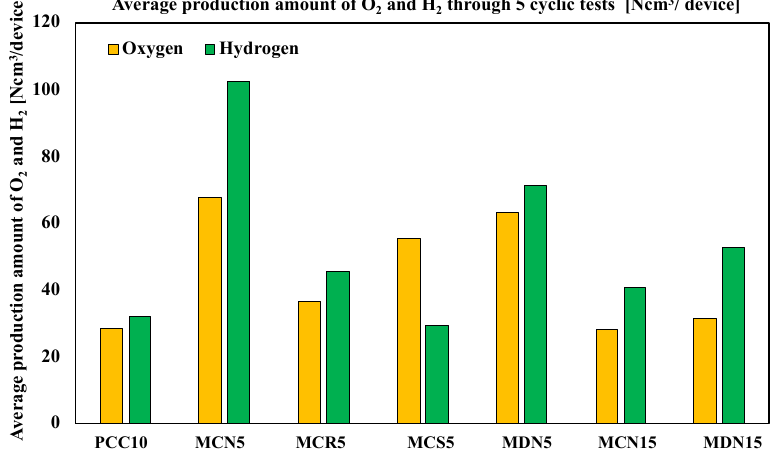
Figure 9. Average production amount of O 2 and H 2 through 5 cyclic tests (Ncm 3 /device). The amount of Mn content in the Mn-CeO 2 for both the co-precipitation and